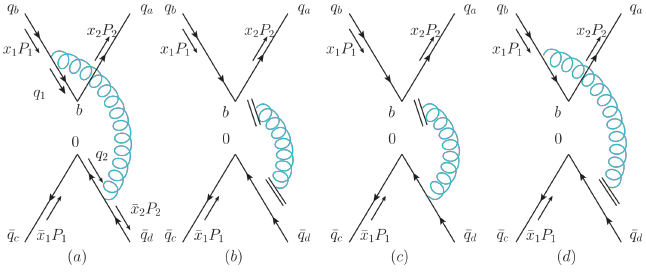
Figure 7 . Factorization of form factor shown in figure 5(c). The collinear, and soft modes contribute in this diagram, while the hard mode’s contribution is power